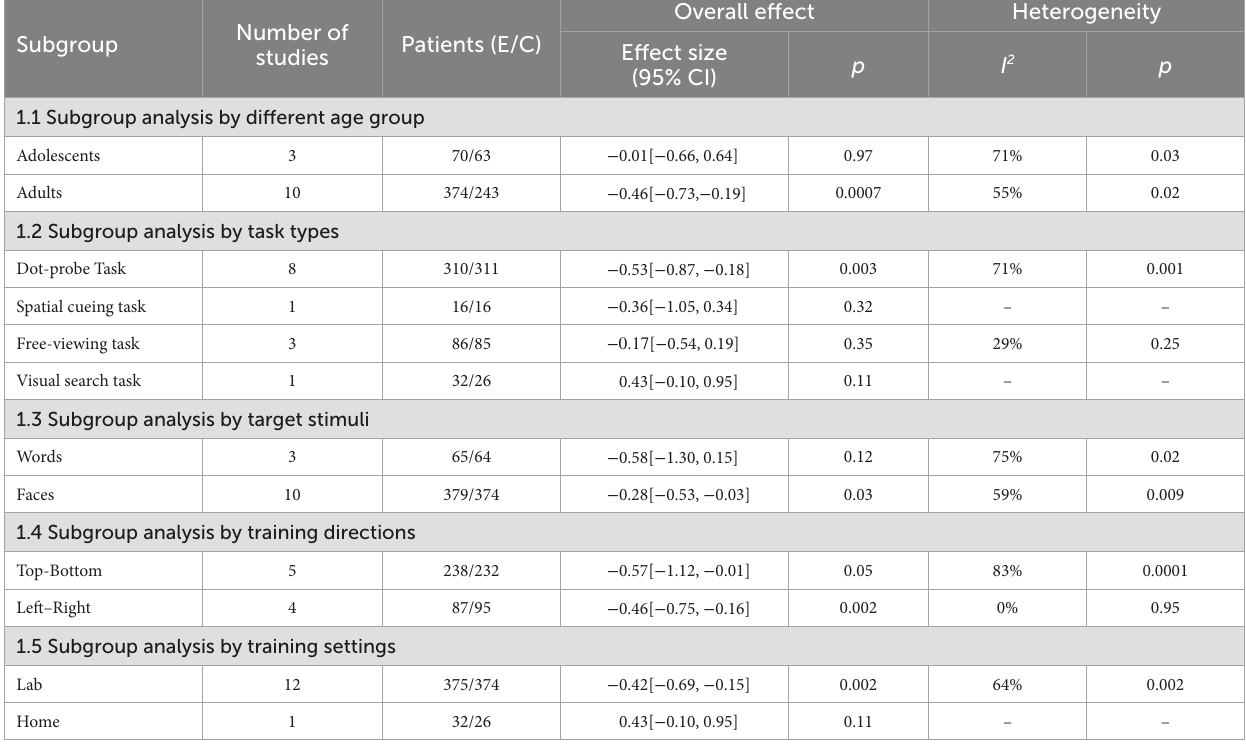
TABLE 2 Subgroup analyses of depression outcome in comparison with ABM versus ACT.